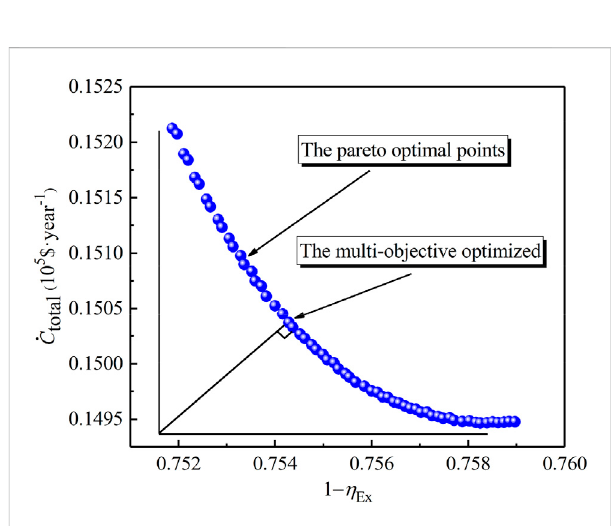
FIGURE 10 Pareto optimal Frontier from multi-objective